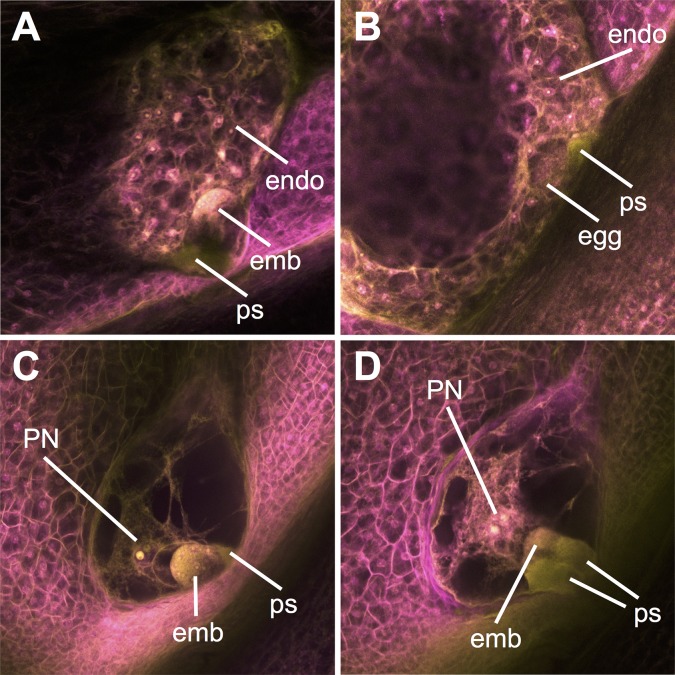
Pollination by gex2-tdsgR84A12 leads to aberrant fertilization events and developing seed phenotypes.(A) Seed development in a typical ovule pollinated by wild-type pollen, with one synergid penetrated by a pollen tube, and both embryo and endosperm development initiated. (B-D) Abnormal phenotypes seen following gex2-tdsgR84A12 pollination. (B) Ovule with developing (cellularizing) endosperm but unfertilized egg cell. (C) Ovule with developing embryo but unfertilized central cell. (D) Ovule with both synergids penetrated by a pollen tube, and a developing embryo and unfertilized central cell. emb = embryo; endo = endosperm; ps = synergid penetrated by a pollen tube; PN = polar nuclei.